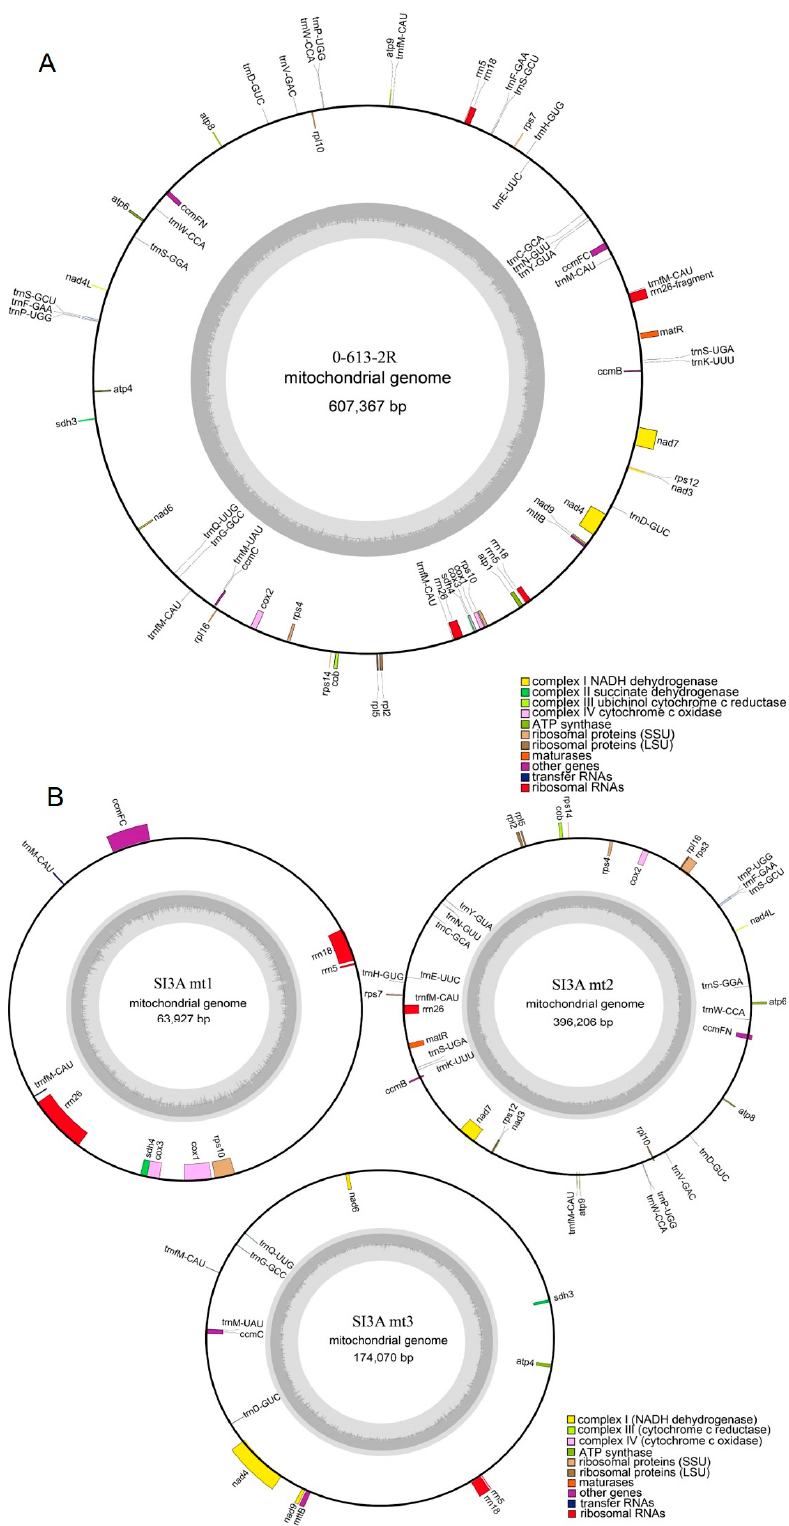
Figure 3. Mitochondrial genome map of the restorer line, 0-613-2R, and the CMS line, SI3A. ( A ) Mito- chondrial genome map of restorer line, 0-613-2R. ( B ) Mitochondrial genome map of CMS line, SI3A. Genes inside the loop represent transcription in a clockwise direction, while genes outside the loop are in the opposite direction. Different functional genes are marked with different colors. The built-in gray histogram shows the genomic GC content, and the middle gray line is the 50% threshold